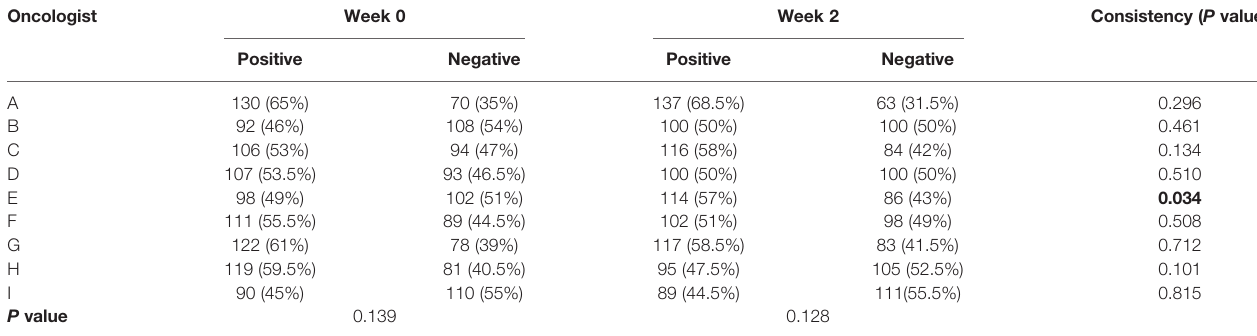
TABLE 4 | The results of the Turing-like imitation test. Oncologist